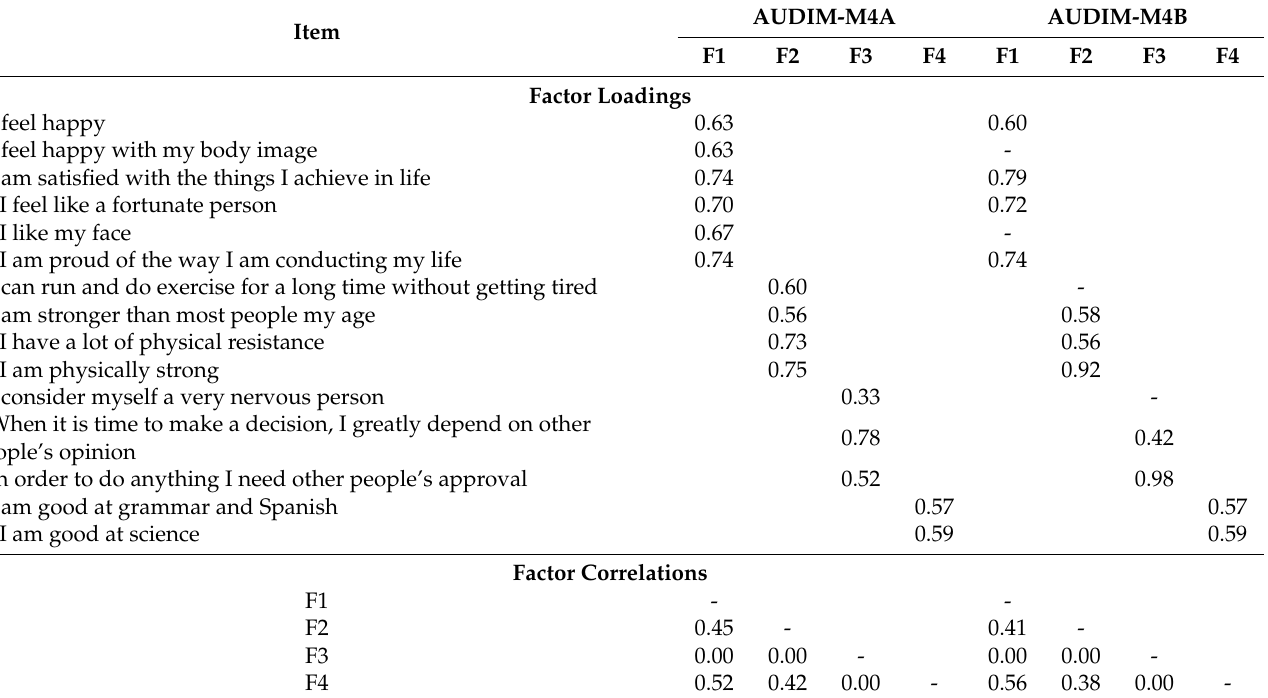
Table 2. Standardized solutions from the confirmatory factor analysis for the models AUDIM-M4A y AUDIM-M4B.